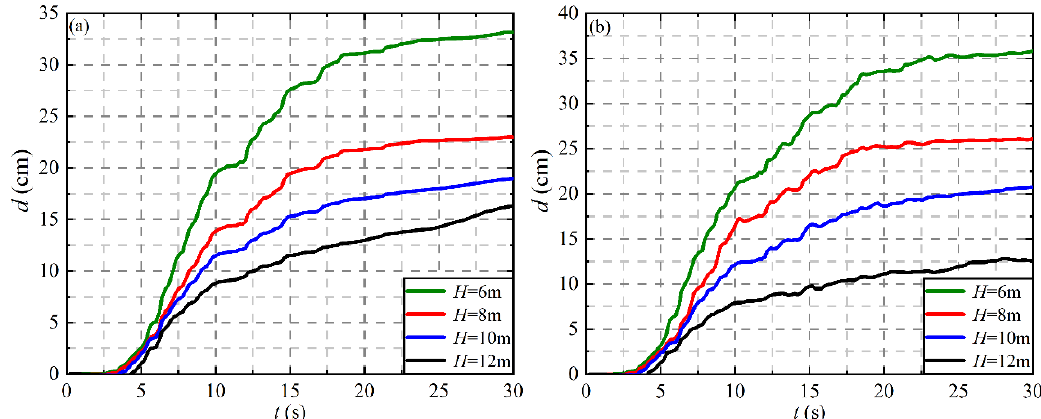
Figure 16. Comparison of time history curve of the upward displacement of the tunnel under different embedment depths: ( a ) H = 6 m; ( b ) H = 8 m; ( c ) H = 10 m; ( d ) H = 12 m.